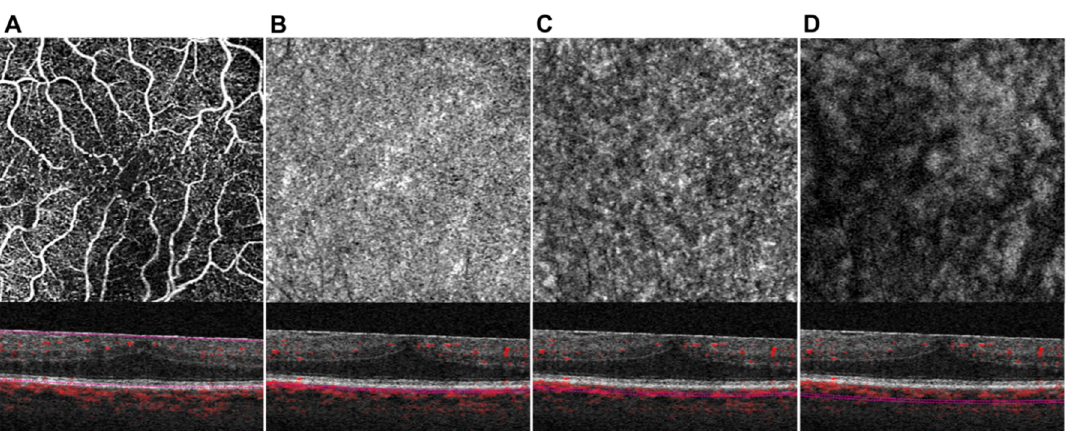
Figure 1. Optical coherence tomography angiography (OCTA)-Imaging of the posterior pole in a subject with idiopathic epiretinal membrane (iERM). En face angiogram and corresponding B-scan at the level of the full retina ( A ), choriocapillaris ( B ), Sattler’s layer ( C ), and Haller’s layer ( D ).